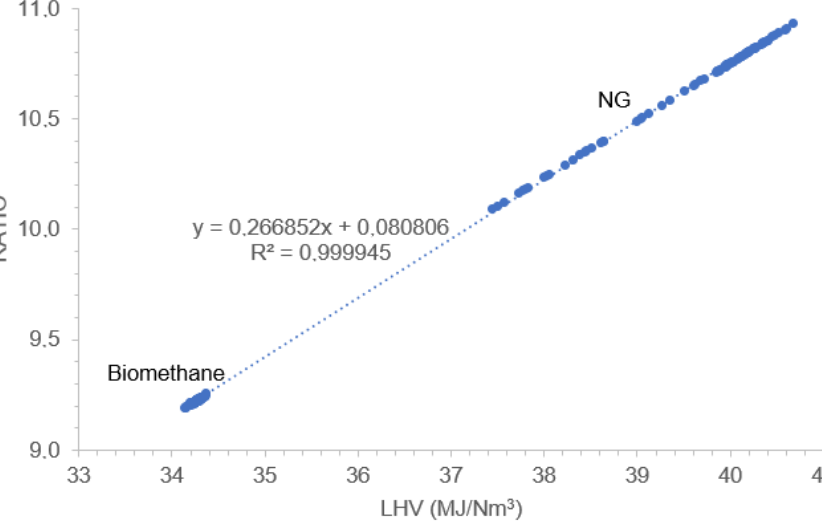
Figure 1. RATIO variation with LHV for NG and biomethane. For the NG, the minimum LHV of the 92 data points was 37.45 MJ/Nm 3 and the maximum value was 40.68 MJ/Nm 3 (8.63% higher). The average was 39.63 MJ/Nm 3 . Also, for NG, the minimum RATIO was 10.09 and the maximum was 8.32% higher at 10.93. The average was